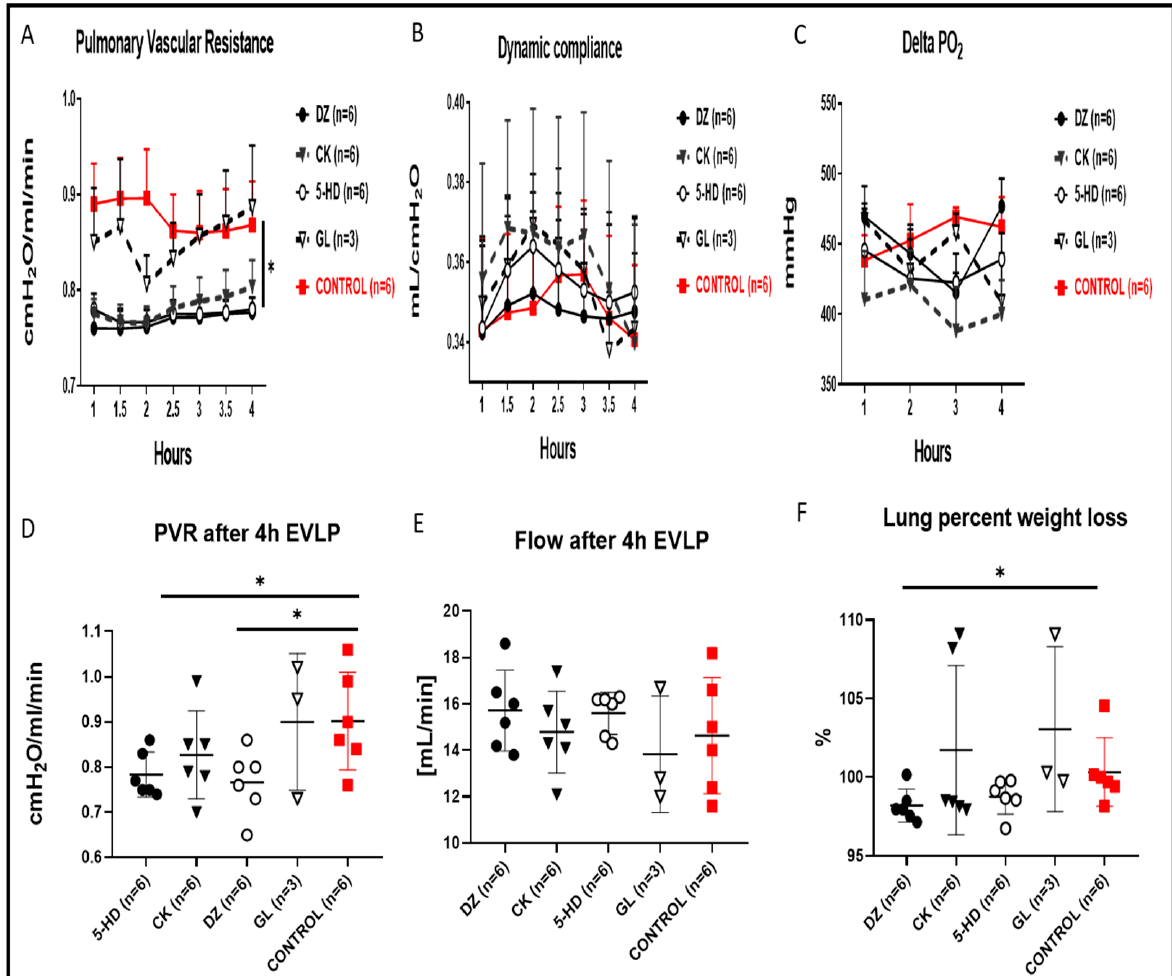
Figure 2. Lung PVR, Cdyn, oxygenation index, flow and percentage lung weight changes during the 4 h EVLP and following the end of the experimental EVLP stress test. ( A ) PVR in DZ and 5-HD was significantly lower than that of the control (* p < 0.05), whereas the PVR observed in the GL condition overlapped the control. ( B ) There were no significant differences in Cdyn between any K(ATP) channel modulators and the control. ( C ) There were no significant differences for the Δ pO 2 between any K(ATP) channels modulators and the control. ( D ) PVR in 5-HD and DZ was significantly lower than that of the control (* p < 0.05), after the end of the EVLP stress test. ( E ) There were no significant differences in flow after 4 h of EVLP between any K(ATP) channels modulators and the control. ( F ) Percentage lung weight after 4 h of EVLP was significantly lower with the DZ condition as compared to the control (* p < 0.05), and lungs treated with 5-HD had a lower weight, but this was not significantly different when compared to the controls.